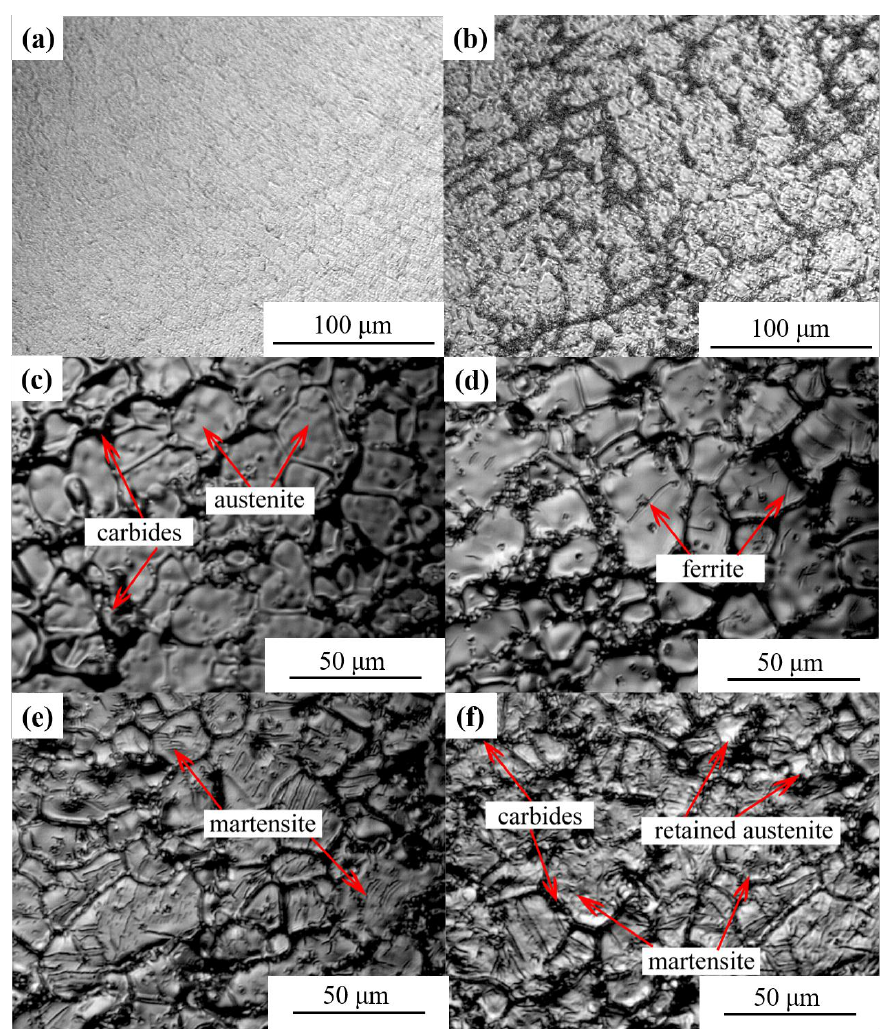
Figure 10. In-situ observation of phase transformation during austenitizing process of AISI M42 HSS with the cooling rate of 5 K/s: ( a ) 1423 K ( × 500); ( b ) 1473 K ( × 500); ( c ) 1473 K ( × 1000); ( d ) 1281 K with the cooling rate of 5 K/s: ( a ) 1423 K (×500); ( b ) 1473 K (×500); ( c ) 1473 K (×1000); ( d ) 1281 K (×1000); ( × 1000); ( e ) 446 K ( × 1000); ( f ) room temperature ( × ( e ) 446 K (×1000); ( f ) room temperature (×1000).